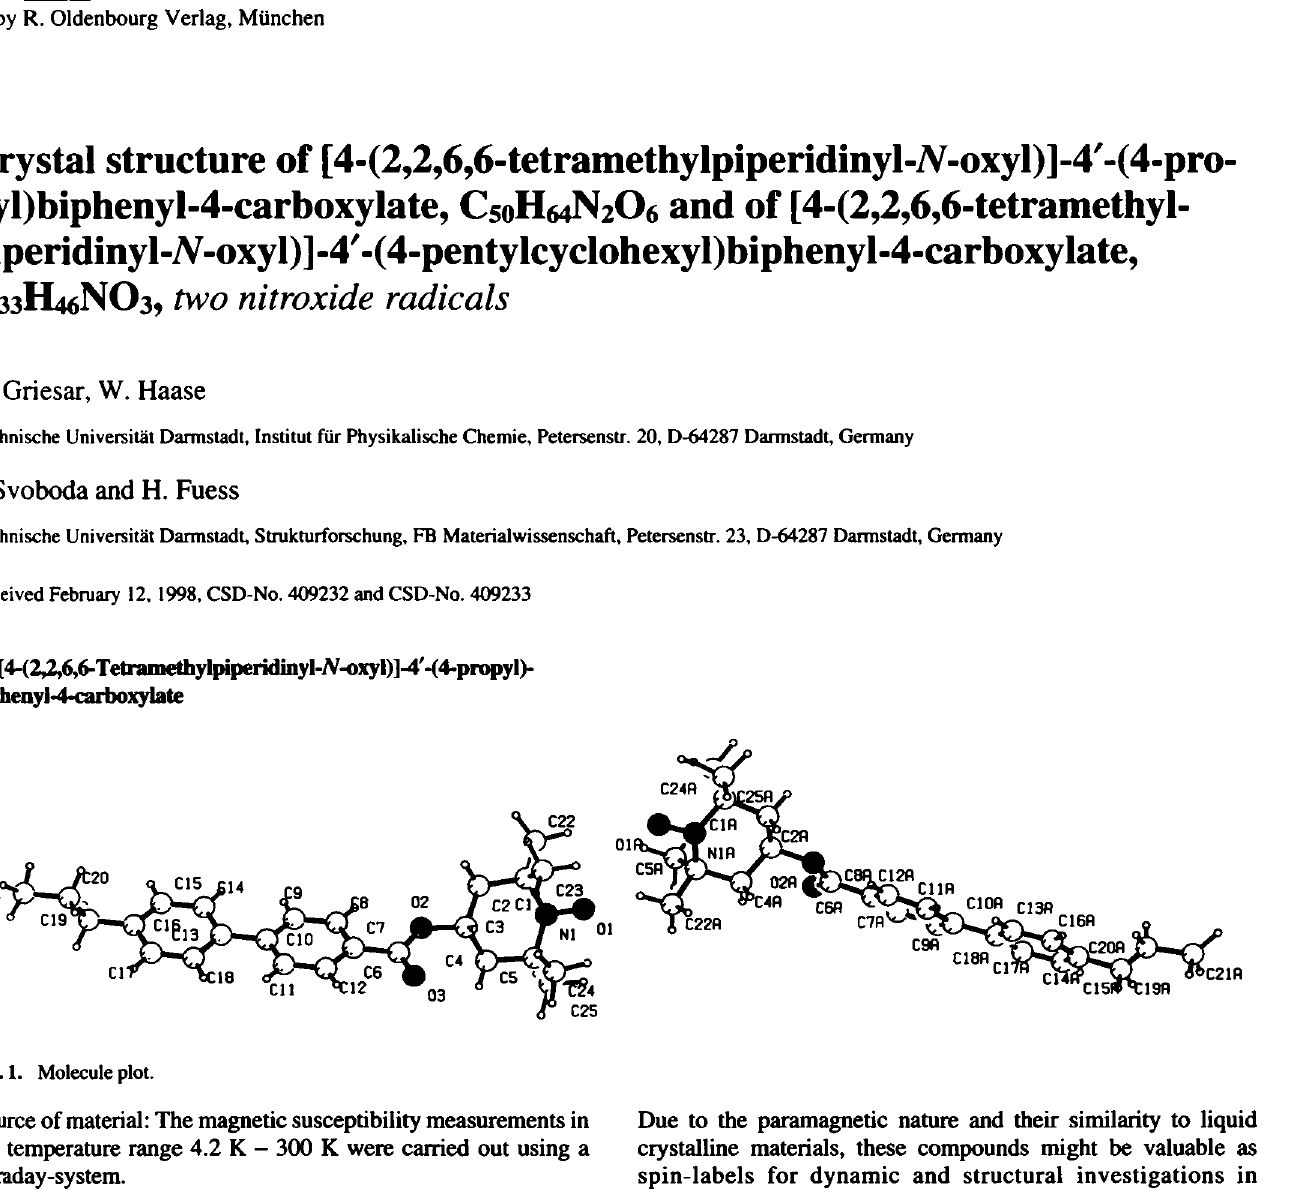
Table 1. Parameters used for the X-ray data collection